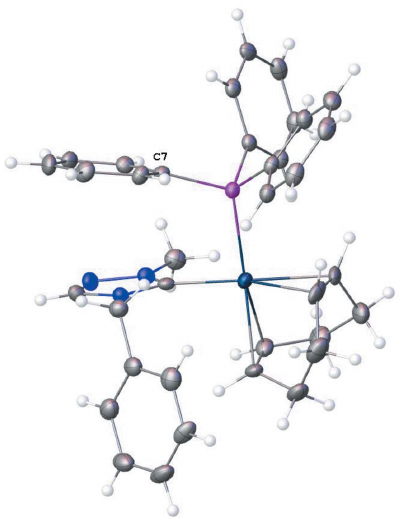
Figure 3 View of the title compound ( 4 ) showing a distorted intermolecular parallel interaction between a phenyl ring (C7) of the triphenyl- phosphane ligand and the NHC ring.